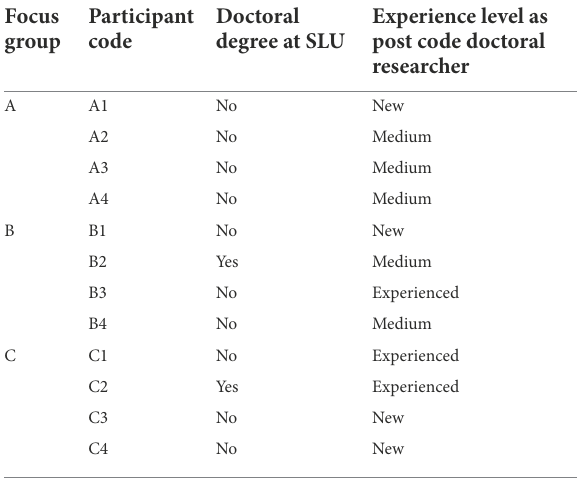
TABLE 2 WECRs’ focus group code, participant code, and doctoral degree completion at the university where the study was based, and time spent as post-doctoral